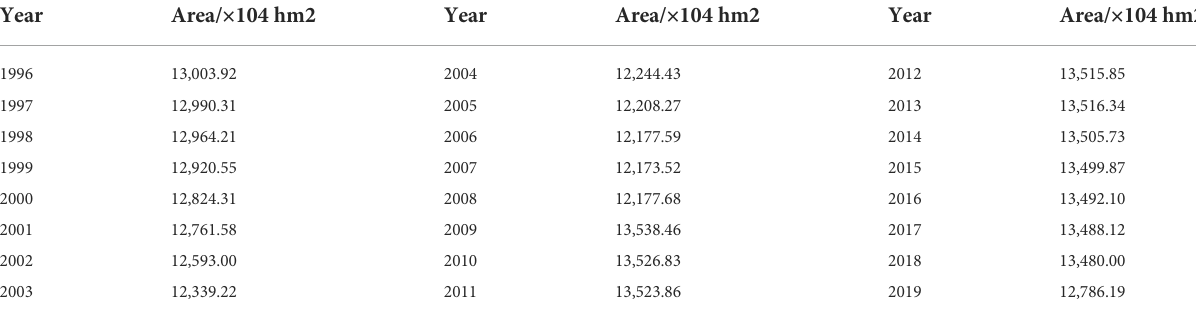
TABLE 1 Of fi cial statistics of cultivated land area in China from 1996 to 2019.